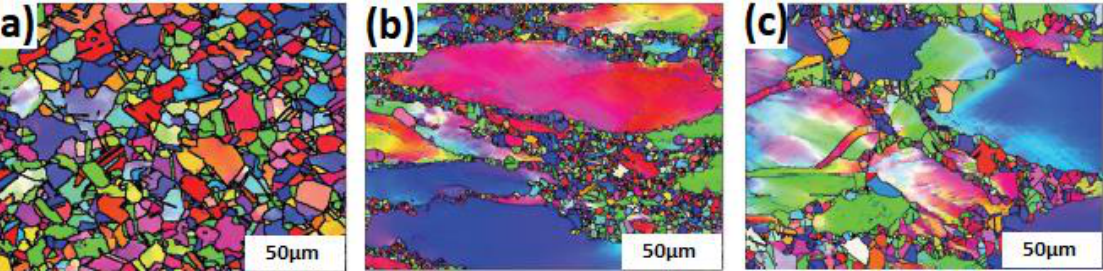
Figure 5. Inverse pole figure maps of microstructures using the EBSD technique on GH690 superalloy at 1000 °C and a true strain of 0.7 for ( a ) 0.001 s −1 , ( b ) 0.1 s −1 , and ( c ) 5 s −1 [136].